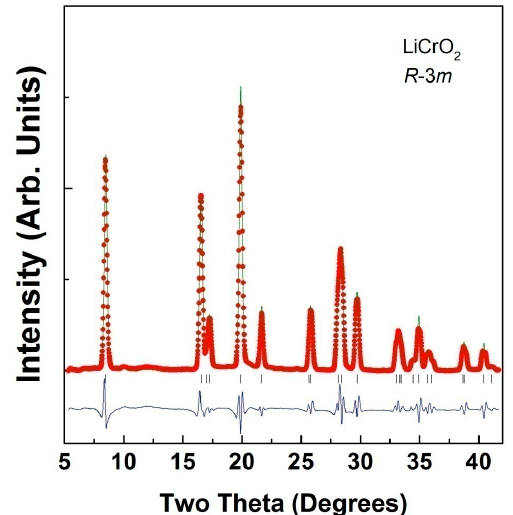
Figure 2. Refined ambient conditions XRD pattern of our LiCrO 2 sample. It shows the single phase formation of the compound. Vertical tick marks represent allowed the reflection of the rhombohedral structure with R -3 m space group.